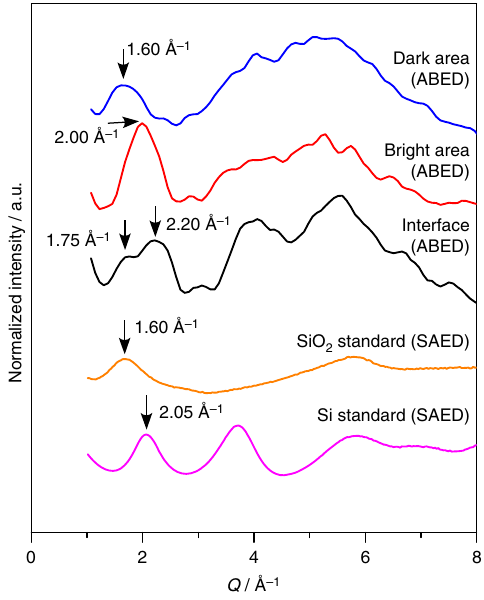
Figure 5 | Integrated intensity profiles of ABED from different domains. The normalized intensity profiles were constructed by integrating 26, 35 and 14 ABED patterns obtained from dark, bright, and interface areas in HAADF-STEM images, respectively. The detailed procedure is described in Supplementary Fig. 2. For comparison, the selected area electron diffraction (SAED) profiles of amorphous SiO 2 and Si are also shown